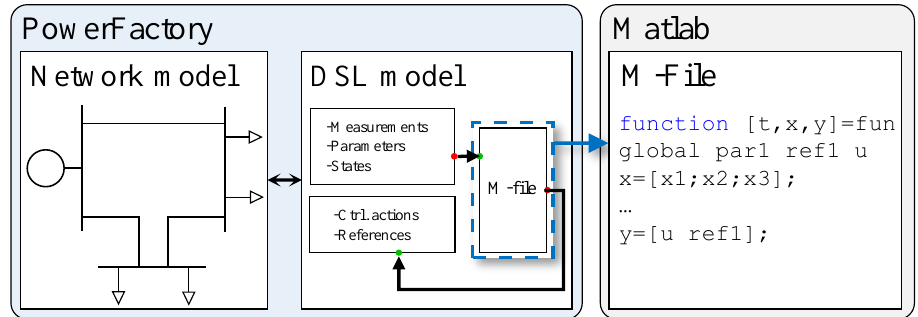
Figure 21. PowerFactory/MATLAB co-simulation